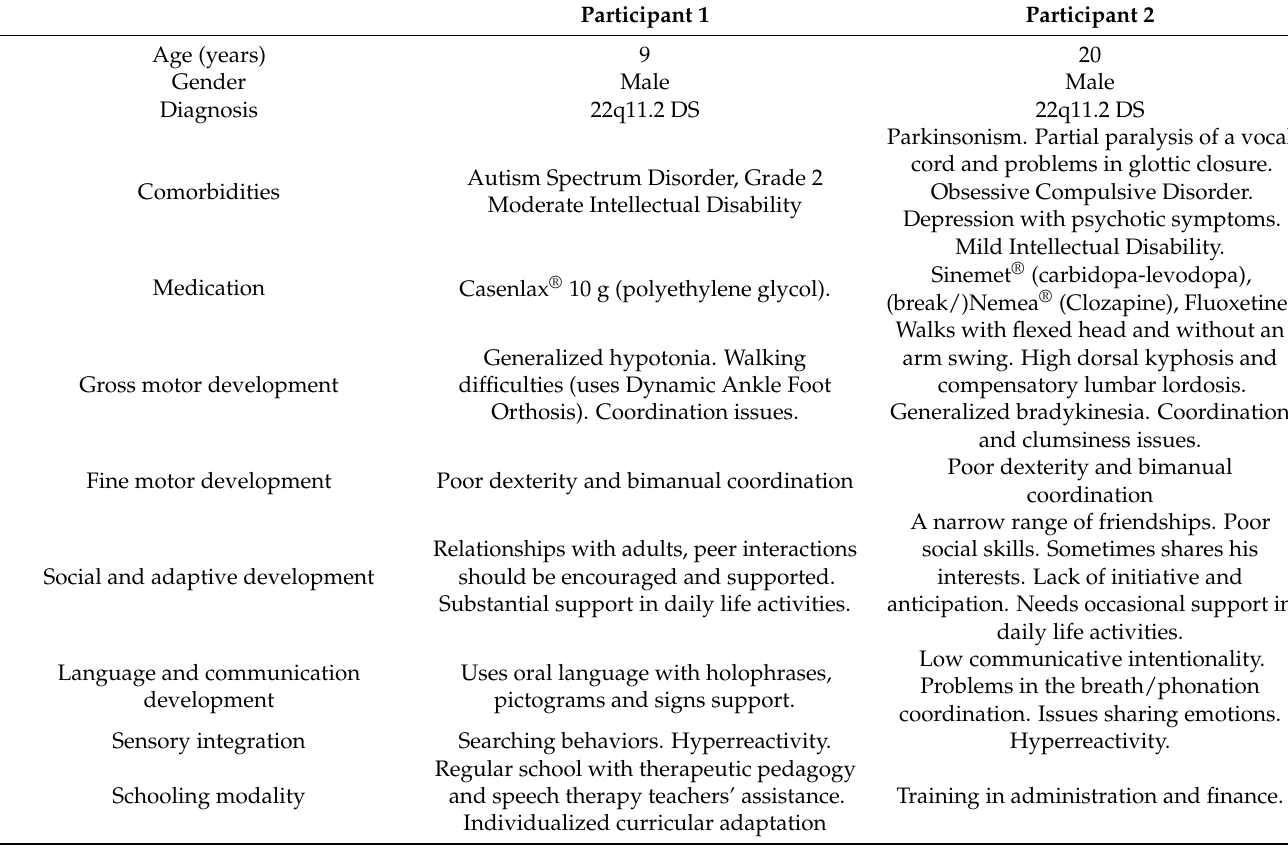
Table 1. Sociodemographic and clinical characteristics of